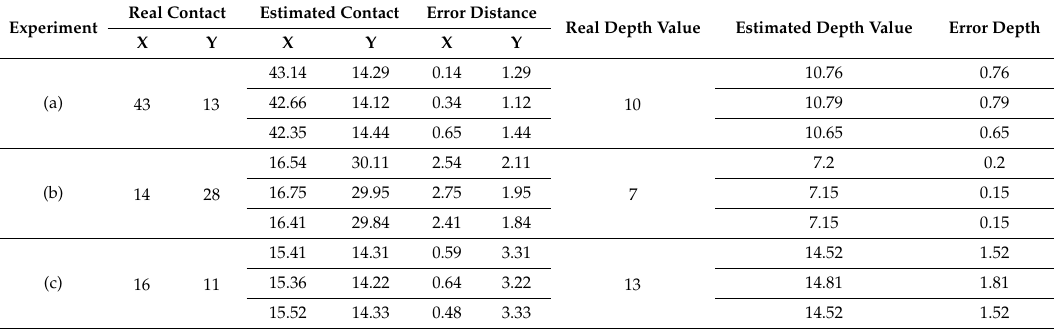
Table 1. Actual contact information and estimated contact information (Unit: mm).